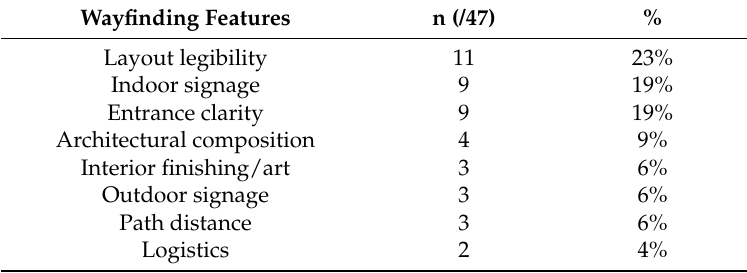
Table 8. Number and percentage of indicators grouped according to Wayfinding